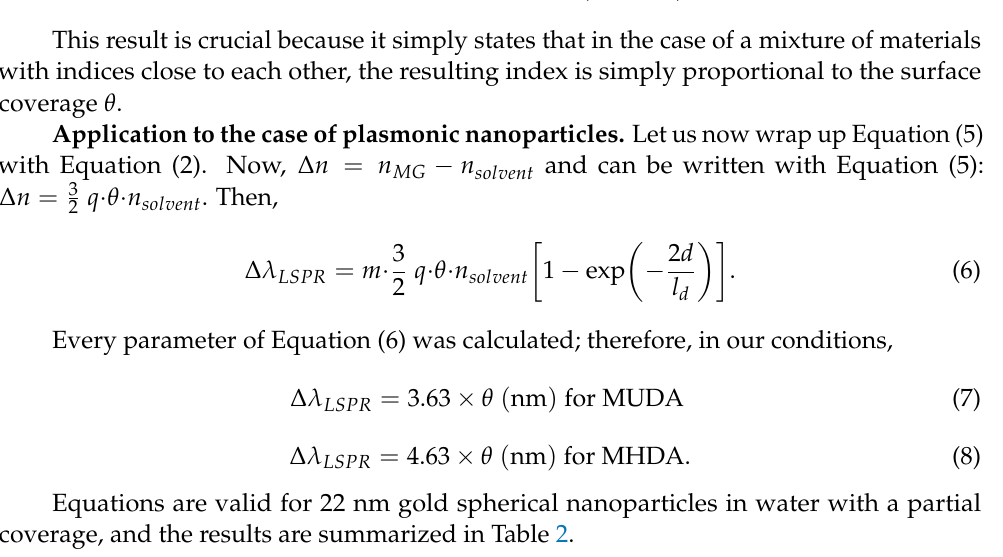
Table 2. Calculated and measured LSPR wavelength shifts for the two molecules of the present study. The molecules length is given assuming a tilt angle from the normal to the surface of α = 30 ◦ . Length Molecules ( d